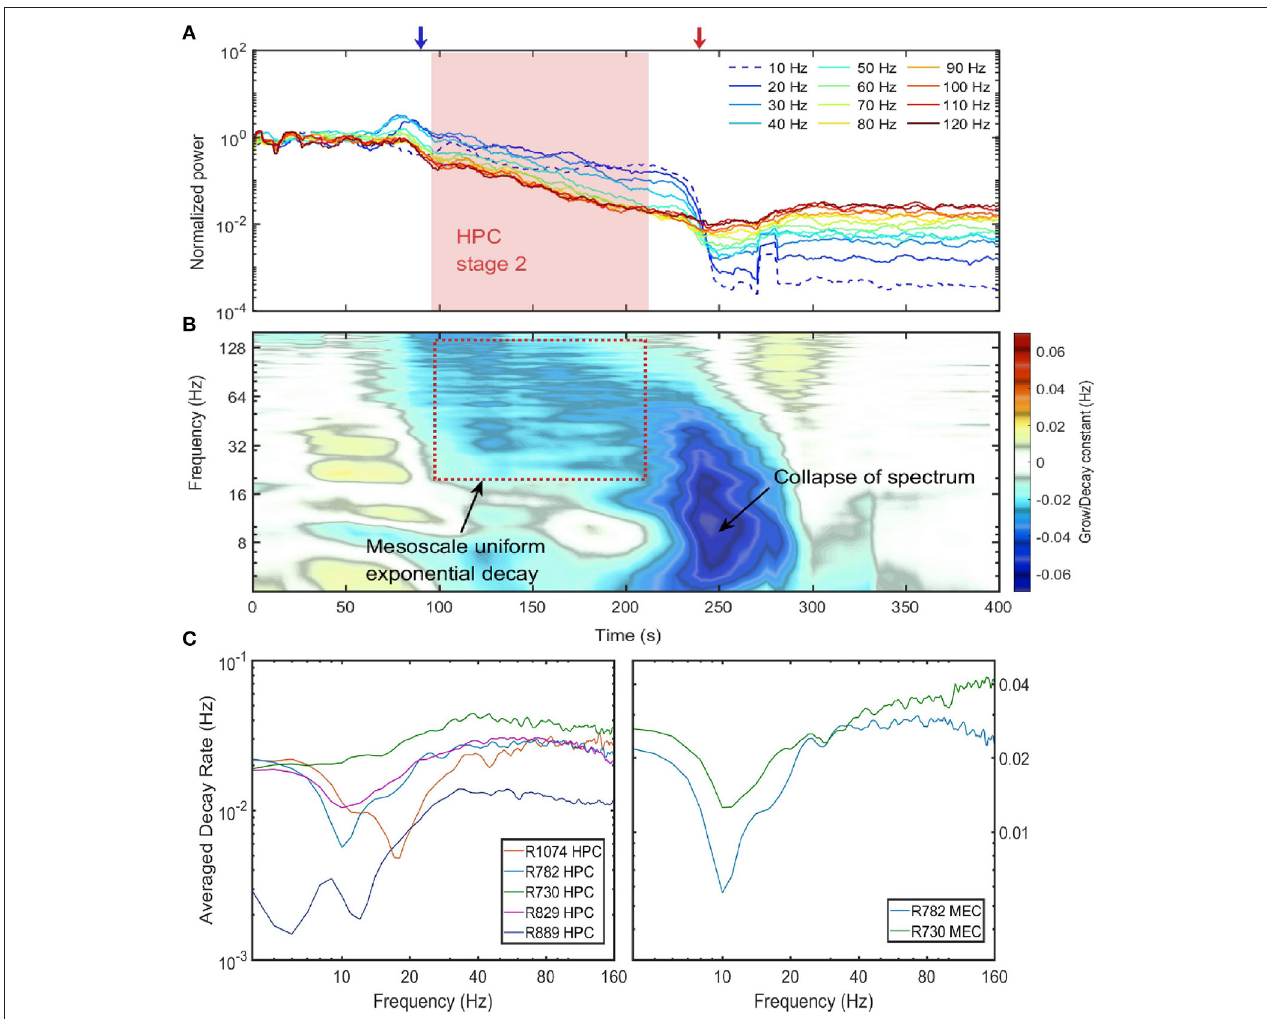
FIGURE 4 | Power decay of frequency components over the euthanasia process. (A) The power evolution for frequency component from 10 to 120 Hz. Each line corresponded to the power decay of one frequency component. Low frequency components were indicated by cold colors and high-frequency components by warm colors. Note the power were normalized by their value at the time of injection ( t = 0), and the 10 Hz frequency component experienced a growth at the end of stage 2. Data from rat 782. (B) The percentage power change rates of different frequency components over the entire spectrum degradation process. To obtain the percentage power change rate, the power time series for each frequency component was first estimated and the percentage power change rate was defined as the ratio of the time derivative of power time series to the power time series. If a frequency component experiences a exponential decay or grow e α t , the percentage power change rate will be a constant with value α . Data from rat 782. (C) The decay constant vs. the frequency during the exponential decay stage. The left panel were the decay constants in HPC among rats and the right panel were decay constants in MEC. The decay constant were estimated by averaging over the entire stage 2 period. Note that the overall decay rate of rat 889 was smaller compared with other rats because rat 889 had a longer stage 2 (see Supplementary Figure 6